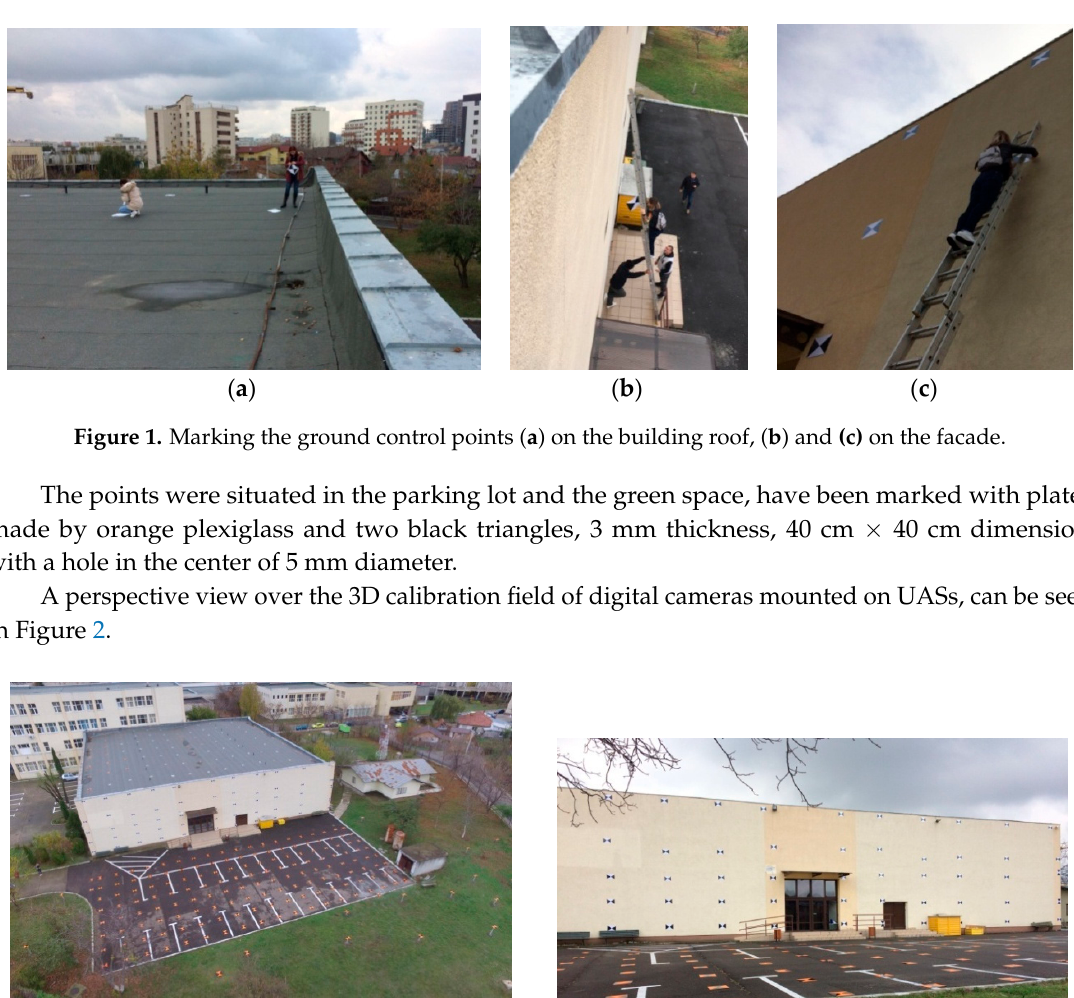
Figure 2. ( a ) UAS image over the 3D calibration field of digital non ‐ metric cameras mounted on Unmanned Aerial Systems, ( b ) ground image.